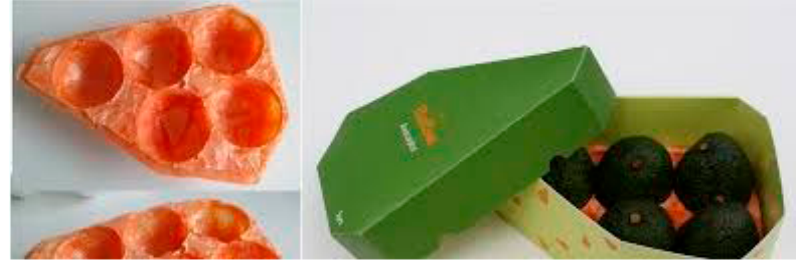
Figure 4. Potential aerogel food package [39].